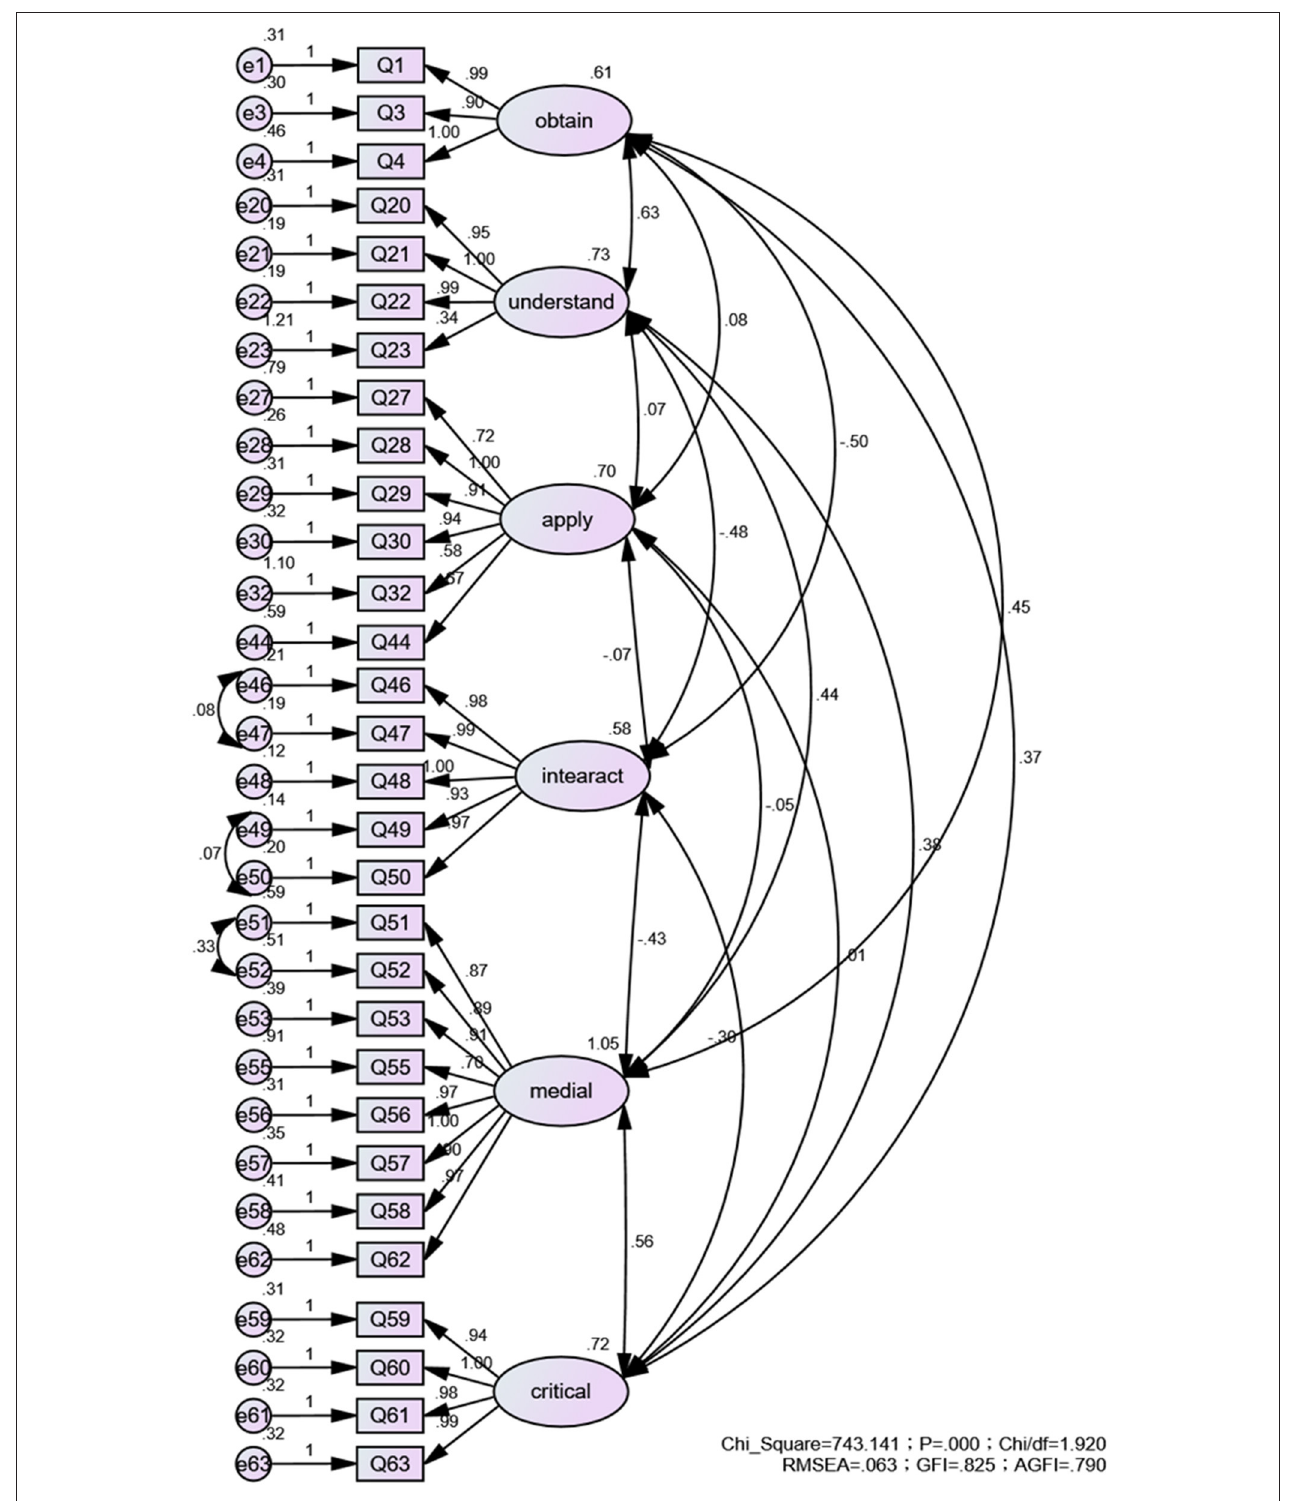
FIGURE 2 | First-order CFA analysis factor loading construct validity study for CM-NL.